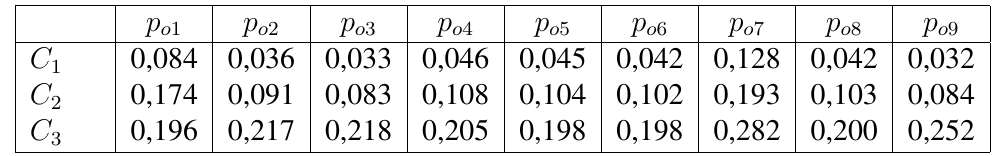
Table 5: Local priorities p